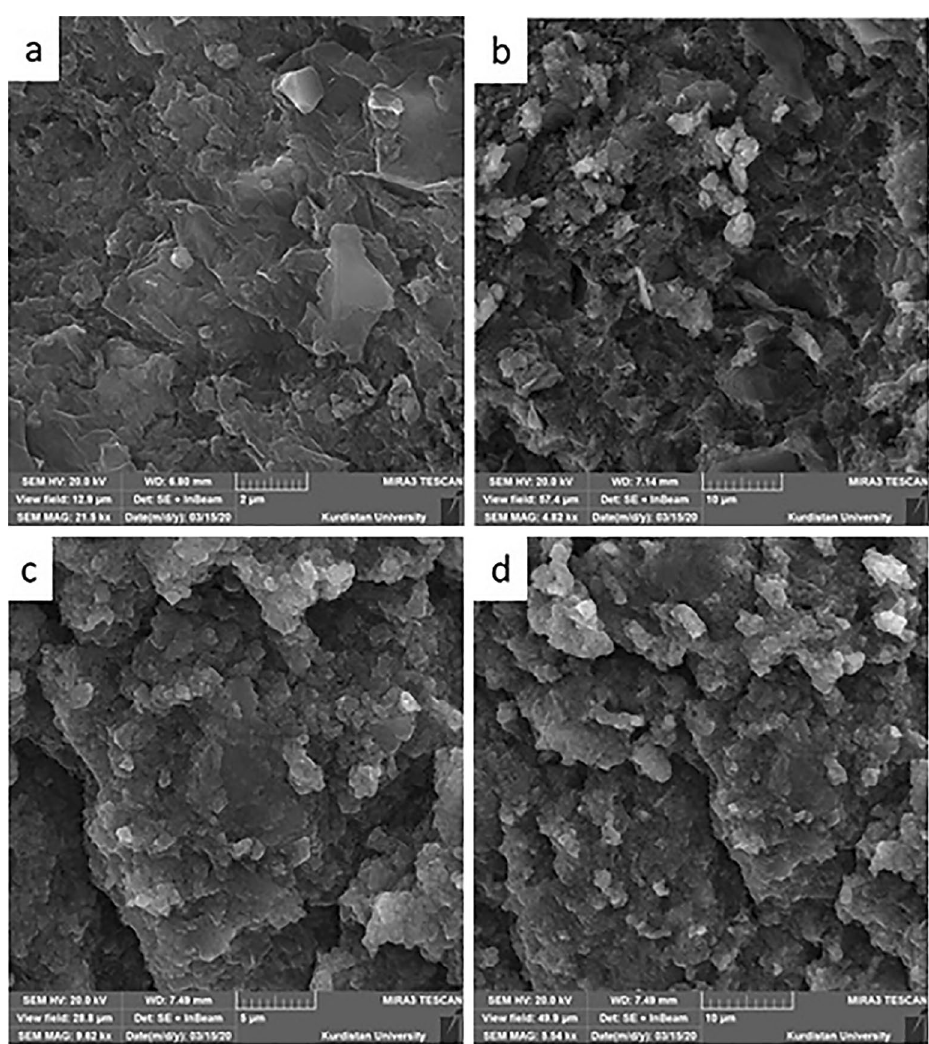
Figure 4. SEM micrograph of GO ( a ), GO-CuFe 2 O 4 ( b ) and SSE@GO-CuFe 2 O 4 ( c , d ).